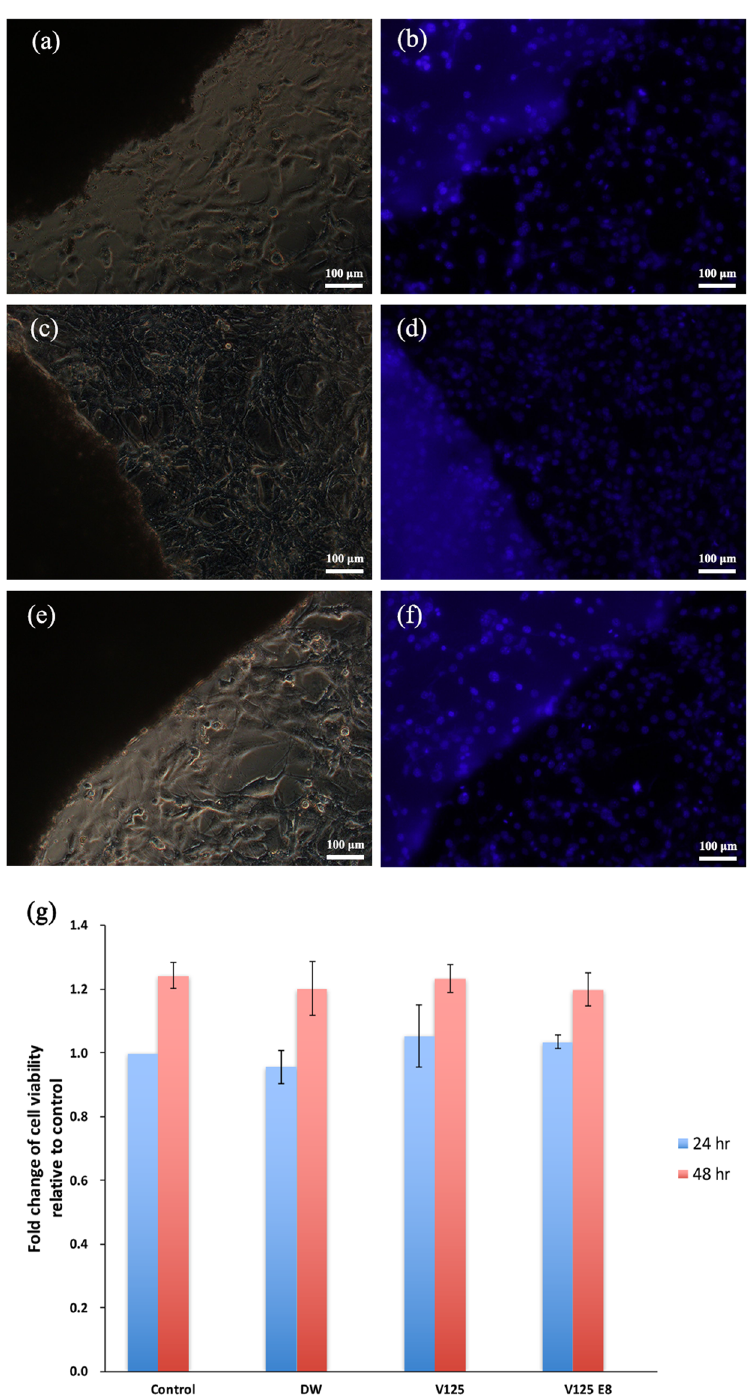
Figure 6. Cell attachment and viability tests. Parts ( a – f ) show attached cells at the CPC boundary in light microscope and fluorescence images of the same area [DW group, ( a ) and ( b ); V125, ( c ) and ( d ); V125-E8, ( e ) and ( f )]. NIH3T3 cells showed good distribution on CPC; no specific differences among groups were found. The cell viability increased after 48 h compared to 24 h in all groups ( p < 0.05), and there was no significant difference among groups ( p > 0.05) ( g